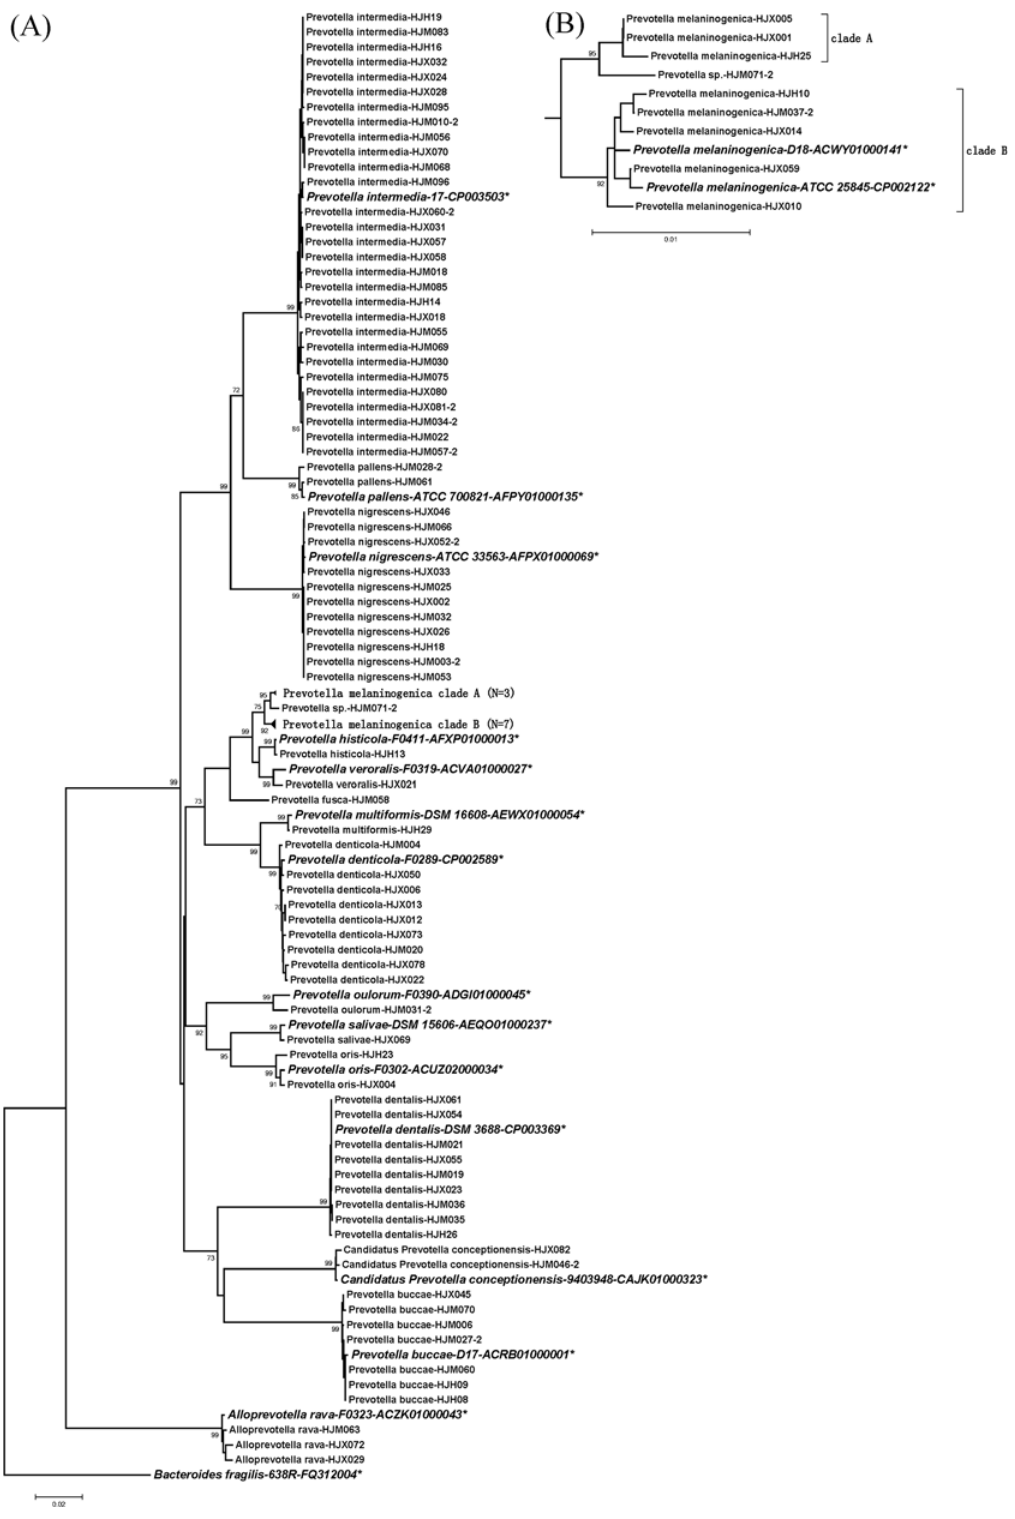
Fig 3. Phylogenetic trees based on the concatenated sequences of the 16S rRNA gene. Detailed phylogenetic trees of P . melaninogenica strains are shown in Figure (B). The trees were constructed by the neighbour-joining (NJ) method. The numbers at nodes indicate the percentage bootstrap values of 1000 replicates ( > 70%). Bars indicate the expected nucleotide substitutions per site. * represents reference